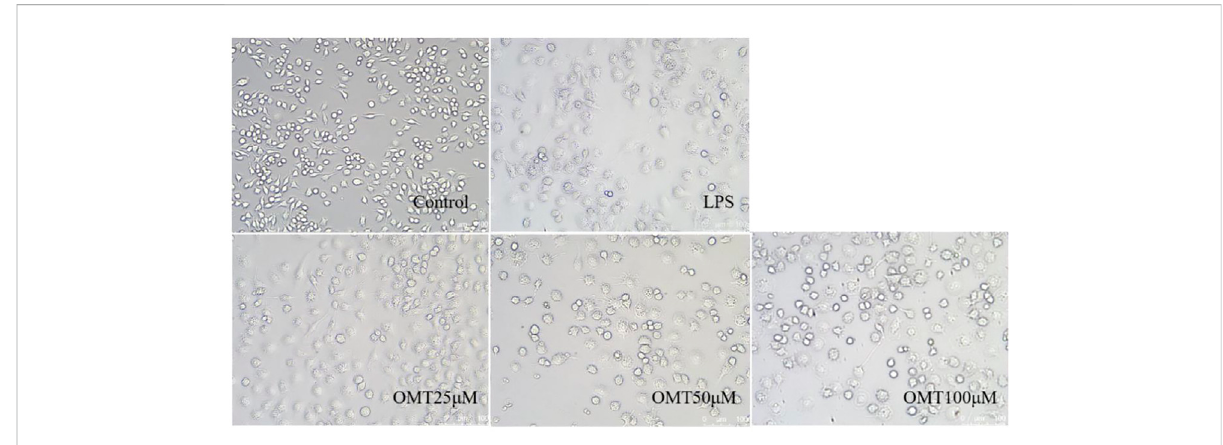
FIGURE 8 The effect of OMT on the cell morphology of LPS-induced RAW264.7 cell in fl ammation model. Each group was visualized by an ordinary light microscope (× 200 magni fi